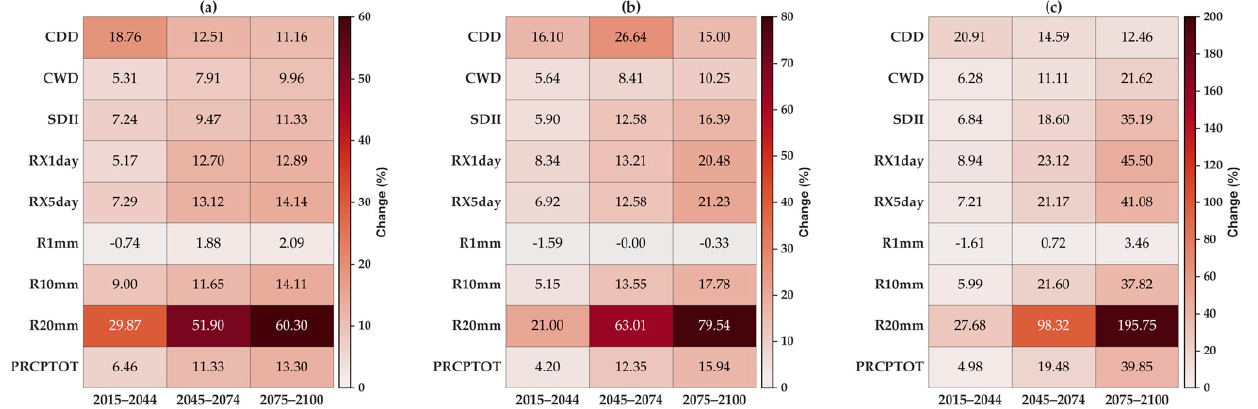
Figure 4. Projected changes [near-future (2015–2044), mid-future (2045–2074), distant-future (2075– 2100)] in precipitation extremes under ( a ) SSP1-2.6 ( b ) SSP2-4.5 and ( c ) SSP5-8.5 over GRB.